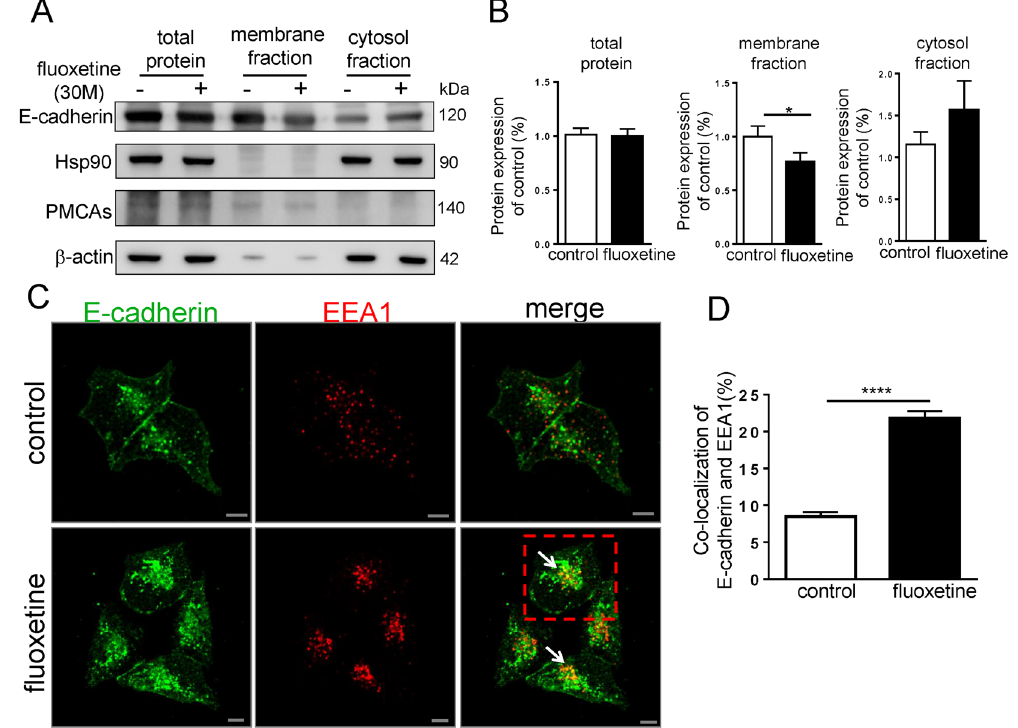
Figure 4. Fluoxetine reduces the membrane-localized E-cadherin and increases E-cadherin endocytosis. ( A ) After 3-hour incubation with or without fluoxetine (30 μ M), cellular proteins were harvested by using a biotin- surface protein isolation assay, and then analyzed by western blotting. E-cadherin in total lysates, membrane fractions and cytosol fraction are shown. β -actin was used as a loading control for total protein. Hsp90 (heat shock protein 90) was used as a loading control for cytosol fraction. PMCA (calcium pump pan PMCA ATPase) was used as a loading control for membrane fraction. The representative data was from at least 3 independent experiments. Cropped blots have been presented. Full length blots are presented in Supplementary Fig. S6. ( B ) Quantitative analysis of total E-cadherin, membrane E-cadherin and cytosolic E-cadherin expression. Values (means ± SEM) are from three independent experiments. * P < 0.05 ( C ) After 3-hour fluoxetine (30 μ M) treatment, MIN6 cells were fixed and then stained. The representative confocal images show the localization of E-cadherin (green) and EEA1 (red) in MIN6 cells. Nuclei were stained with Hoechst 33258 (blue). White arrows indicate the co-localization of E-cadherin and EEA1. Scale bar, 5 μ m. The representative images were from three independent experiments. ( D ) Co-localization ratio between E-cadherin and EEA1 with pixel- by-pixel analyses. Each value represents mean ± SEM from at least 30 different cells from three independent experiments. *** P <